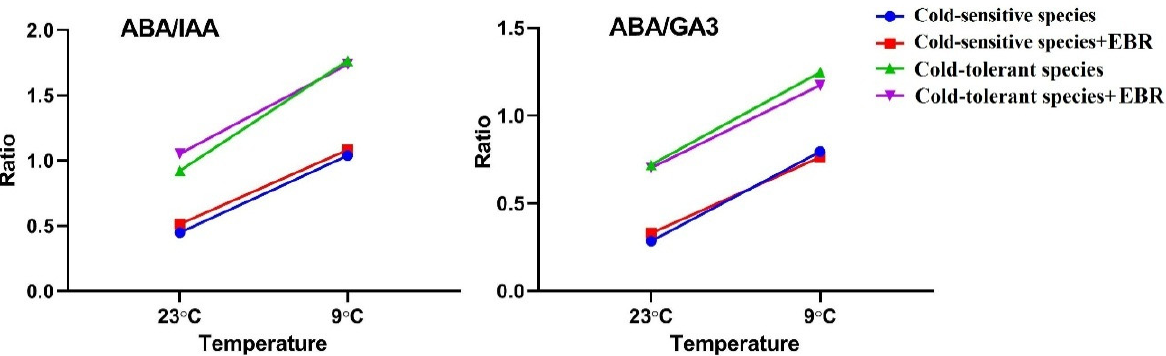
Figure 2. The ration of ABA/IAA and ABA/GA3 under low-temperature stress and EBR application .